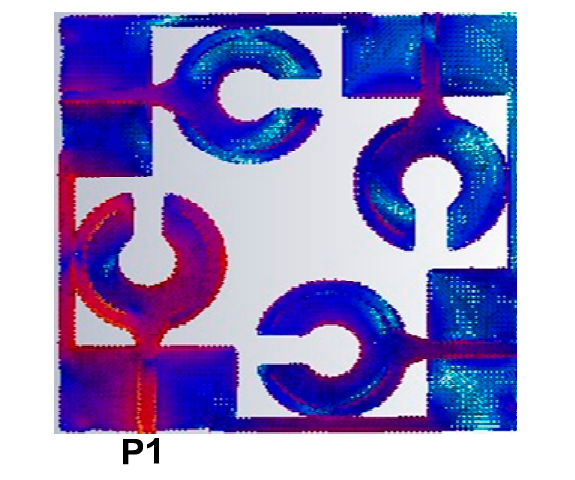
Figure 6. ( a ) Simulated and measured reflection coefficients, and ( b ) simulated and measured mutual coupling between the array ports.